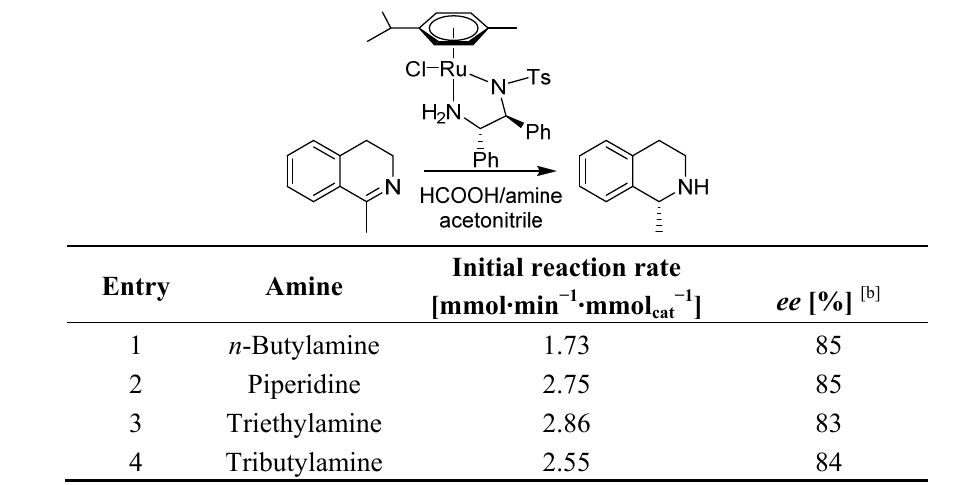
Table 2. ATH of 1-methyl-3,4-DHIQ with [RuCl( η 6 - p -cymene)( S , S )-TsDPEN] and